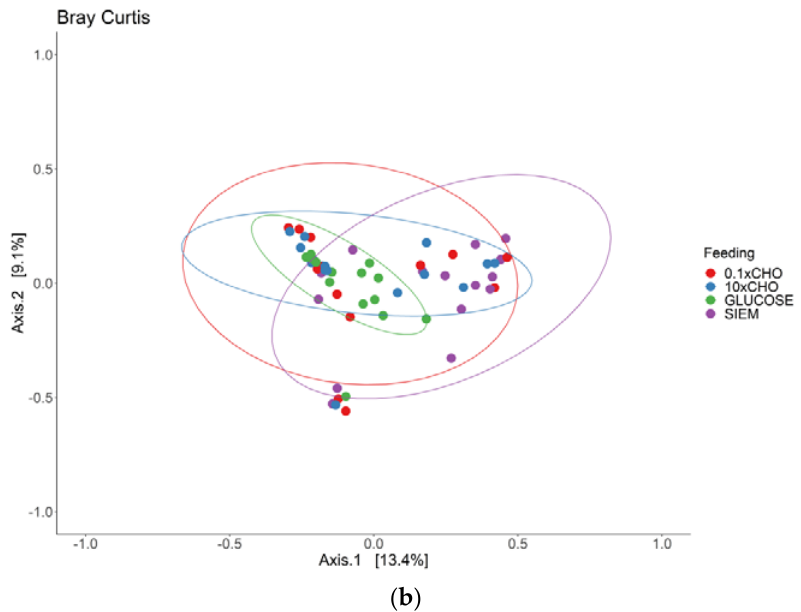
Figure 6. Beta ‐ diversity of the fungal community during the intervention period, visualized using PCoA plot with Bray–Curtis dissimilarity distances; ( a ) between time points for all feeding interventions; ( b ) between feeding interventions for the time points t24, t48 and t72.